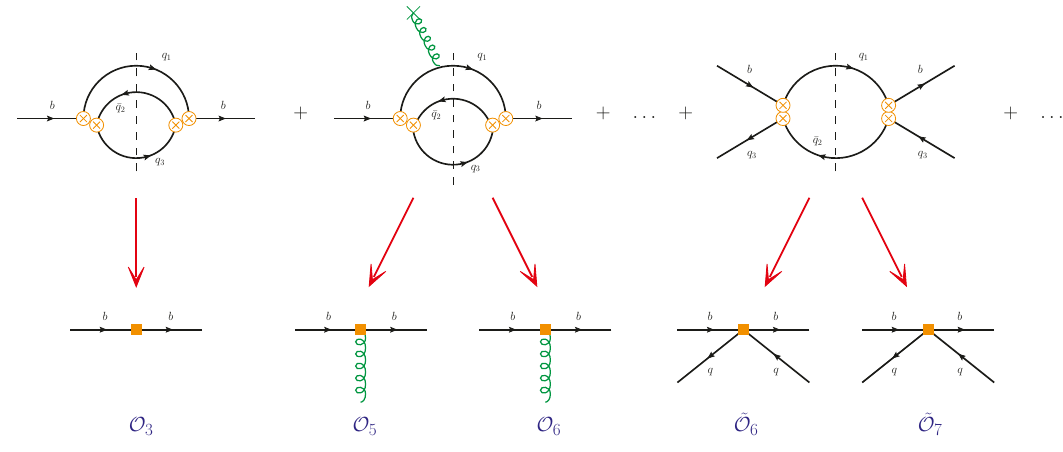
Figure 1 . The diagrams describing contributions to the HQE in eq. (1.4). The crossed circles denote the ∆ B = 1 operators Q i of the effective Hamiltonian while the squares denote the local ∆ B = 0 operators O i and ˜ O i . The two-loop and the phase space enhanced one-loop diagrams correspond respectively to the two-quark operators O i and to the four-quark operators ˜ O i in the